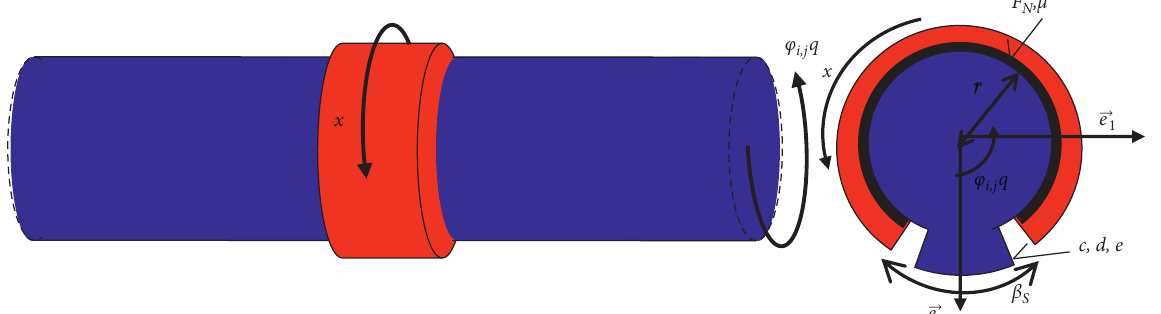
Figure 3: Principle sketch of a shock-friction damper in a drill string.